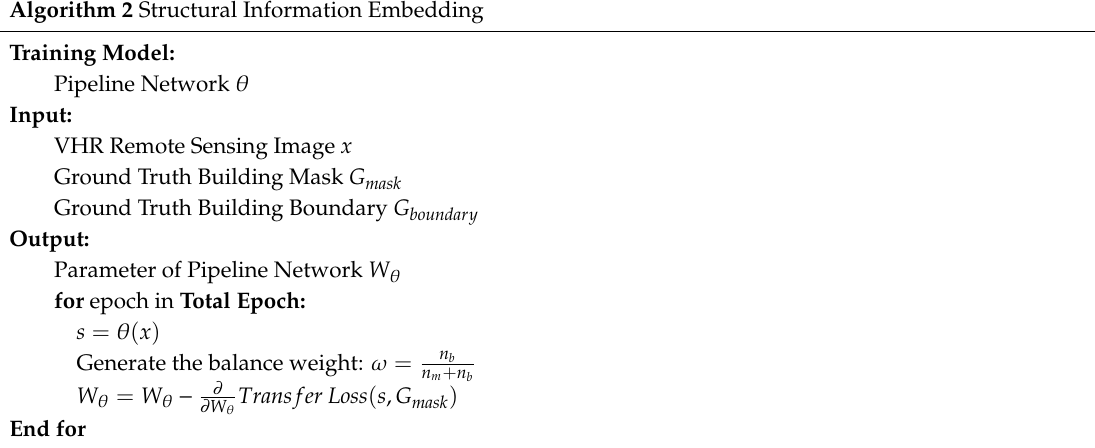
Algorithm 2 Structural Information